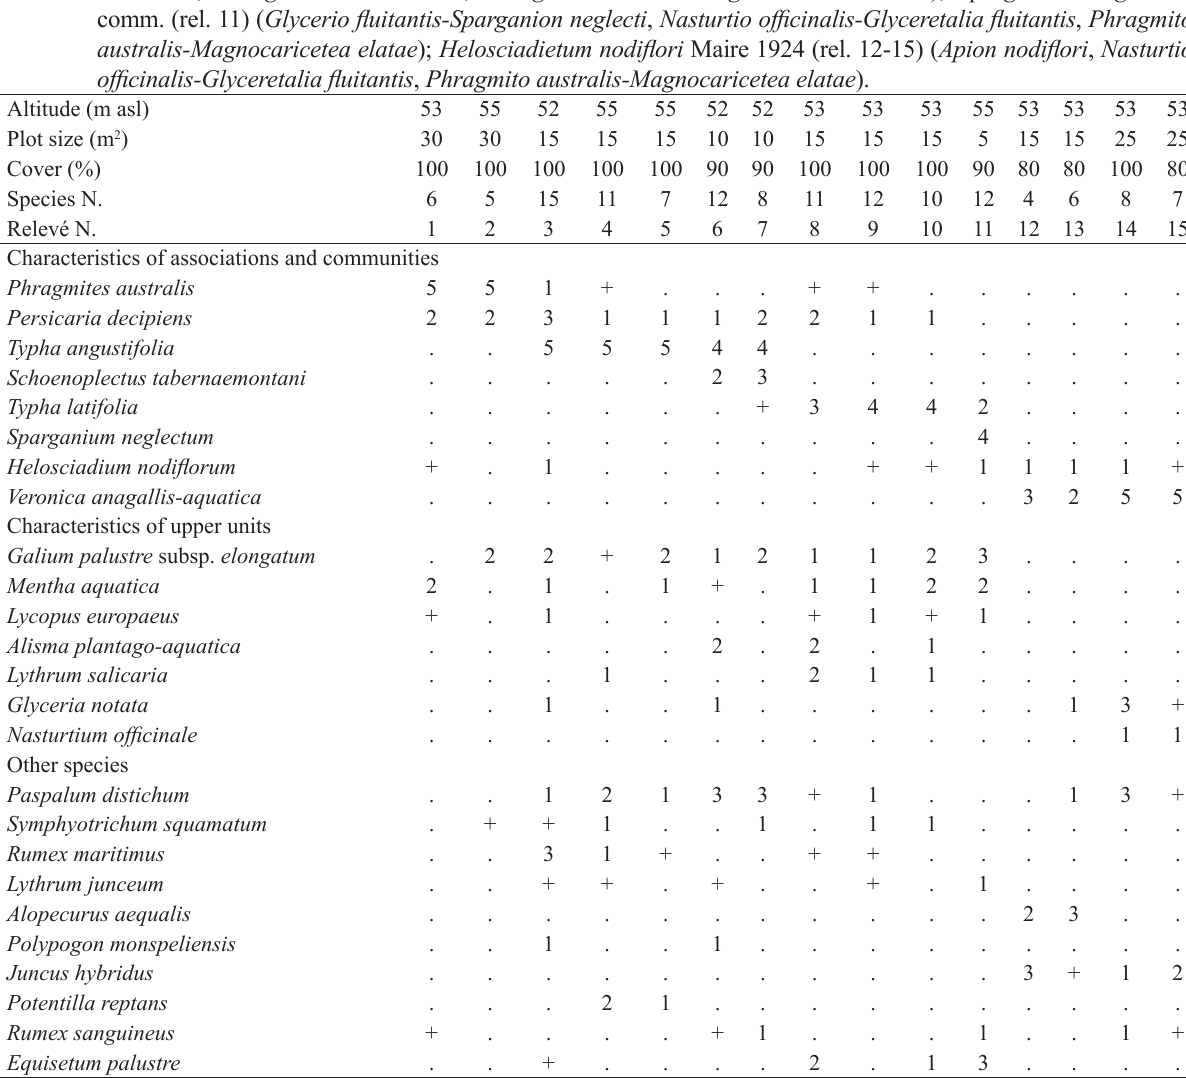
Table 5. Marsh vegetation. Polygono salicifolii-Phragmitetum comunis Barbagallo, Brullo & Furnari 1979 (rel. 1,2), Typhetum angustifoliae (Allorge 1921) Pignatti 1953 (rel. 3-5), Typho